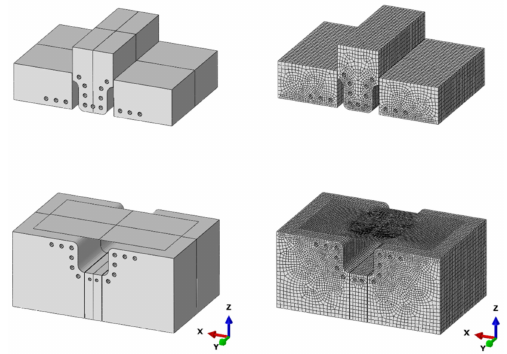
Figure 20. Finite element model for partition-cooling hot forming